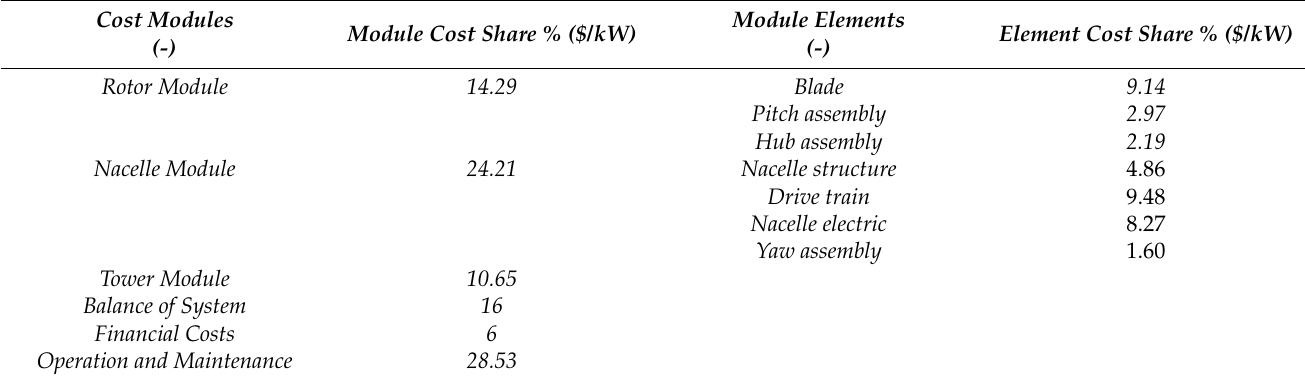
Table 3. Component cost breakdown of wind turbine